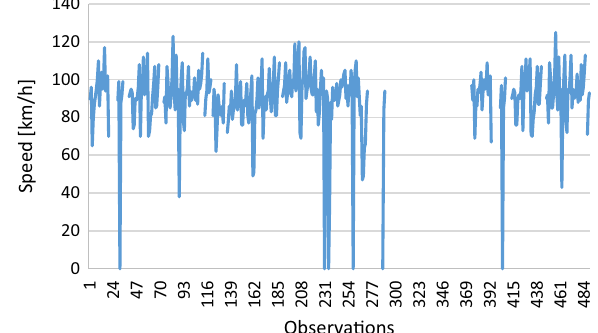
Fig. 2 Data collection based on magnetic sensors